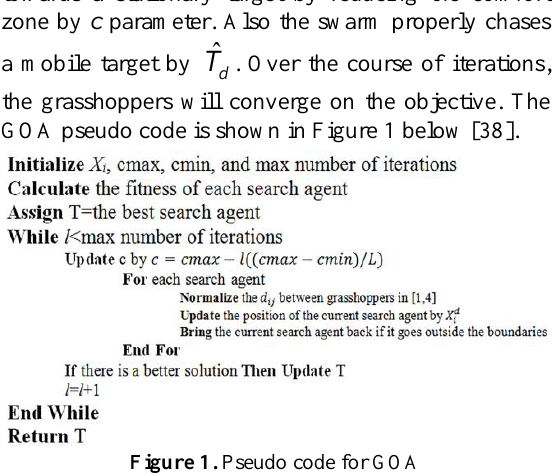
Figure 1. Pseudo code for